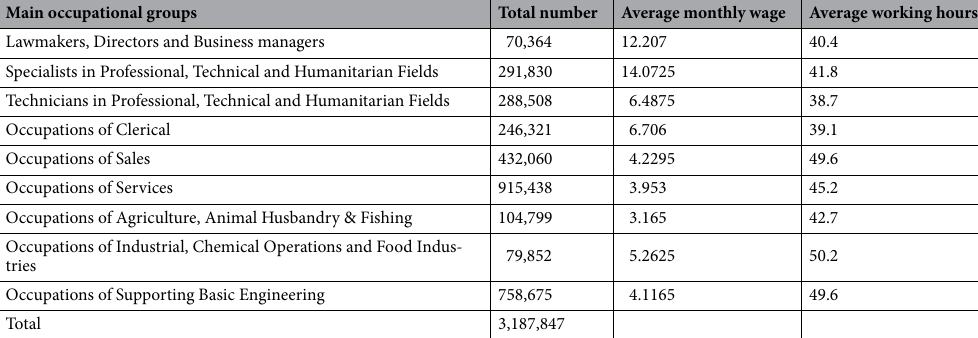
Table 1. Total number of different occupational groups with average monthly wage and average working hours in Makkah region